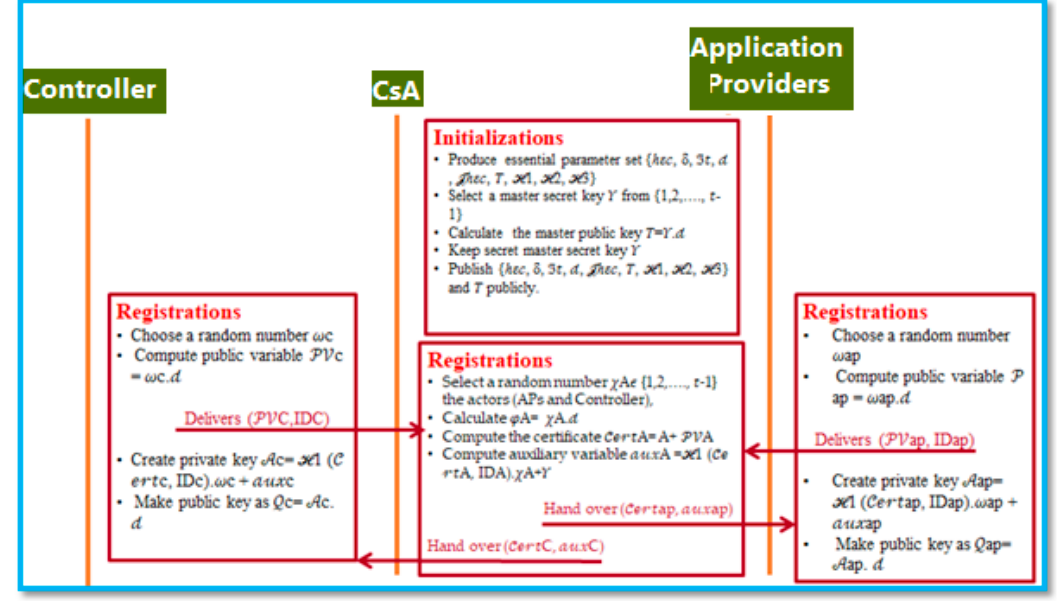
Figure 2. Initialization and registration phase of certificate-based signcryption (CB-SN) access control for wireless body area networks (WBAN).